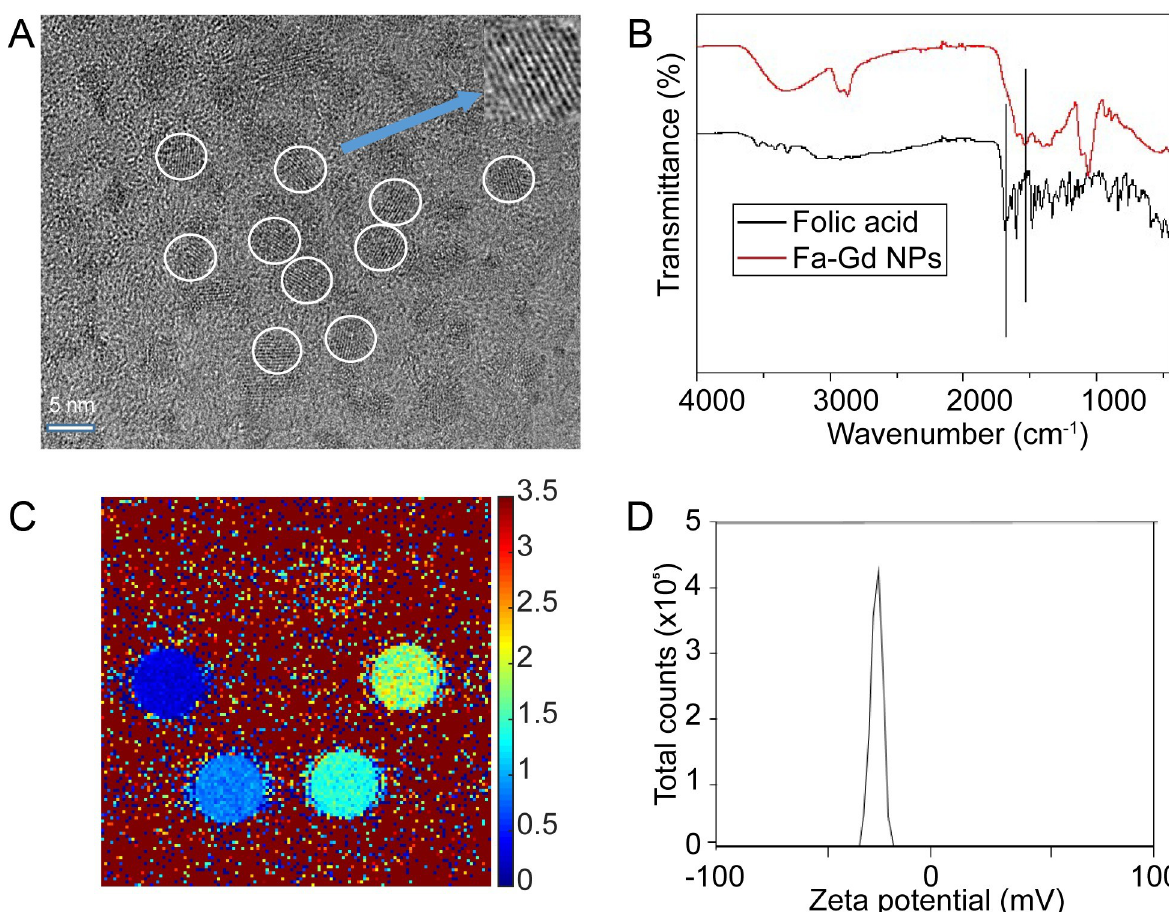
Fig 2. NP structure and properties. (A) HRTEM images of FA-Gd NPs, white circles indicate average diameter (4.5 nm) of the NPs. Blue arrow indicates lattice fringe of NPs. (B) FT-IR spectra of folic acid and FA-Gd NPs. The black spectrum corresponds to free FA, while the red spectrum corresponds to FA-Gd NPs. The COOH peak was shifted from 1680 to 1527 cm -1 , which confirmed the FA coating on to the Gd NPs. (C) R 1 map of FA-Gd NP phantoms for determination of R 1 relaxivity (3.14 mM -1 s -1 ). (D) Zeta potential distribution of FA-Gd NPs, mean value of -40.5 mV.